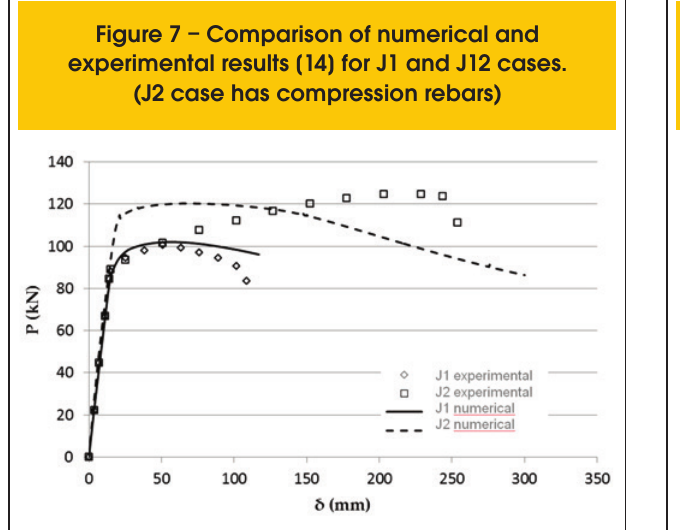
Figure 7 – Comparison of numerical and experimental results [14] for J1 and J12 cases.